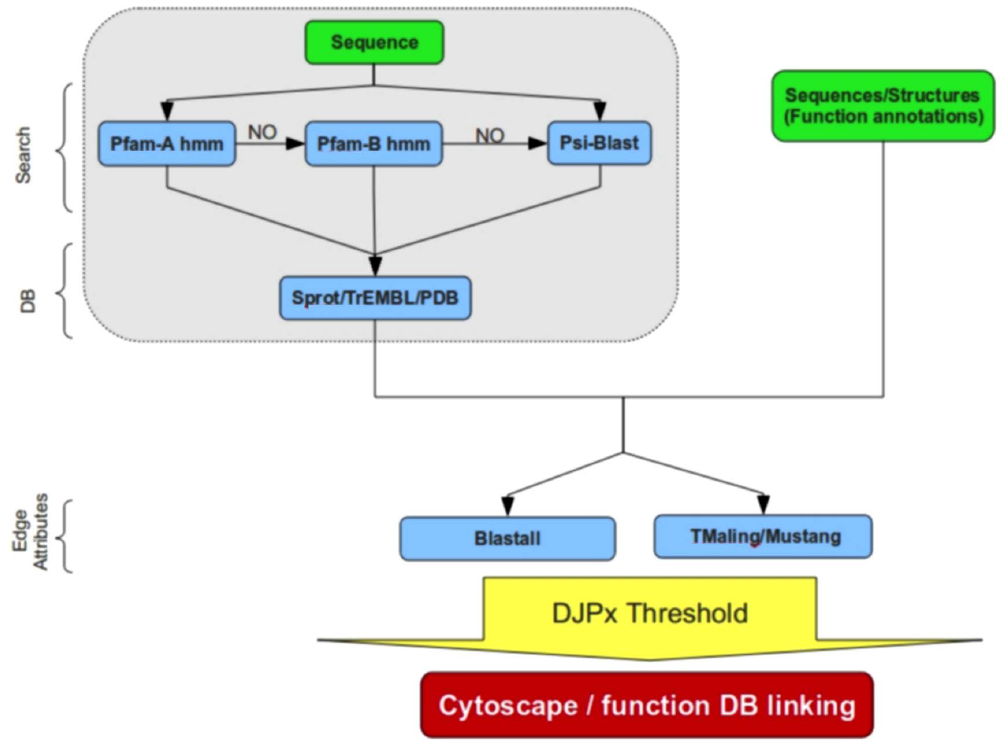
Figure 1. Flow chart of PANADA. An overview of alternative steps performed by PANADA is shown. Depending on the input, a set of proteins, sequences or structures, or a single sequence may be submitted. In the latter case PANADA uses Pfam and/or BLAST to find homologs. Functional annotations may be provided by the user if a set of sequences or structures is uploaded. In all cases the network is generated for a given similarity threshold and with a maximum number of edges per node (DJPx algorithm). The output can then be used in Cytoscape for visual